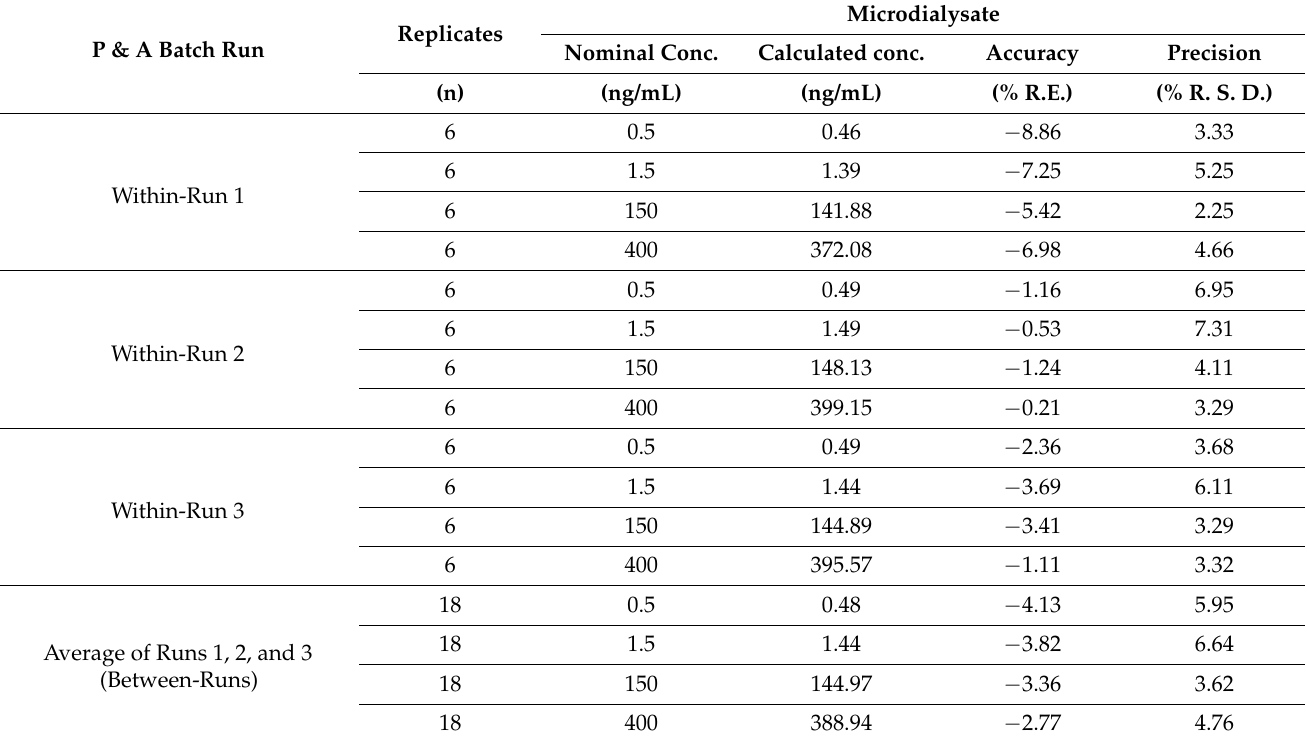
Table 3. Within-run and between-run precision and accuracy for IWR-1-endo in microdialysates (n = 6 for within-run and n = 18 for between-runs).